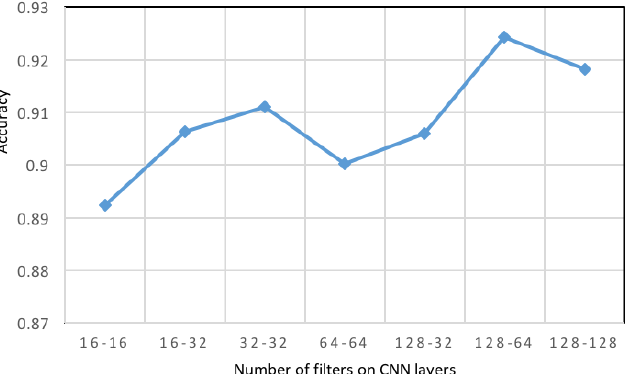
Figure 8. The impact of the number of filters on recognition accuracy in the proposed convolution neural networks